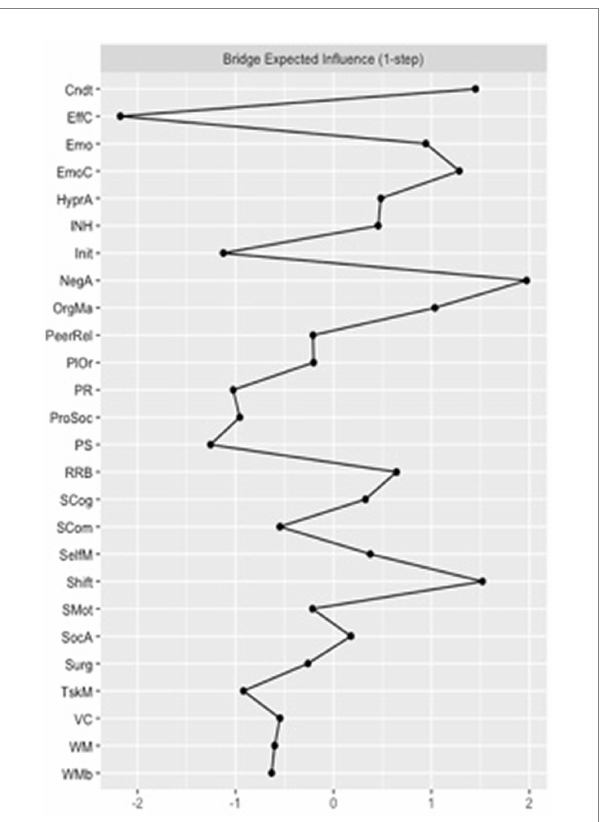
FIGURE 3 Bridge expected influence for the full-term (FT) control group network. Cndt, conduct problems; EffC, effortful control; Emo, emotional problems; EmoC, emotional control; HyperA, hyperactivity; INH, inhibition; Init, initiating behaviors; NegA, negative affectivity; OrgMa, organizing materials; PeerRel, peer relationship problems; PlOr, planning and organizing; PR, perceptual reasoning; ProSoc, prosocial behaviors; PS, processing speed; RRB, rigid and repetitive behaviors; SCog, social cognition; SCom, social communication; SelfM, self-monitoring; SocA, social awareness; Surg, surgency; TskM, task monitoring; VC, verbal comprehension; WM, working memory; WMb, working memory measured by the BRIEF-2.